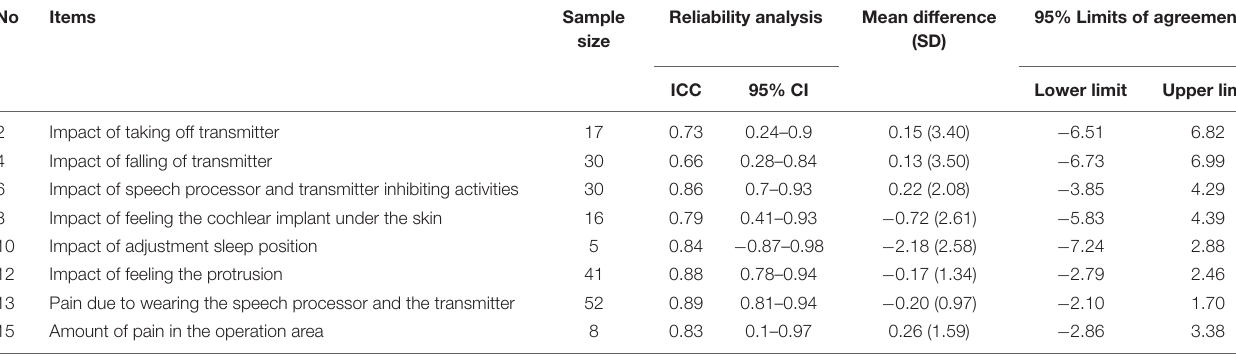
TABLE 3 | Reliability and measurement error analysis for visual analogue scale items (continuous data).